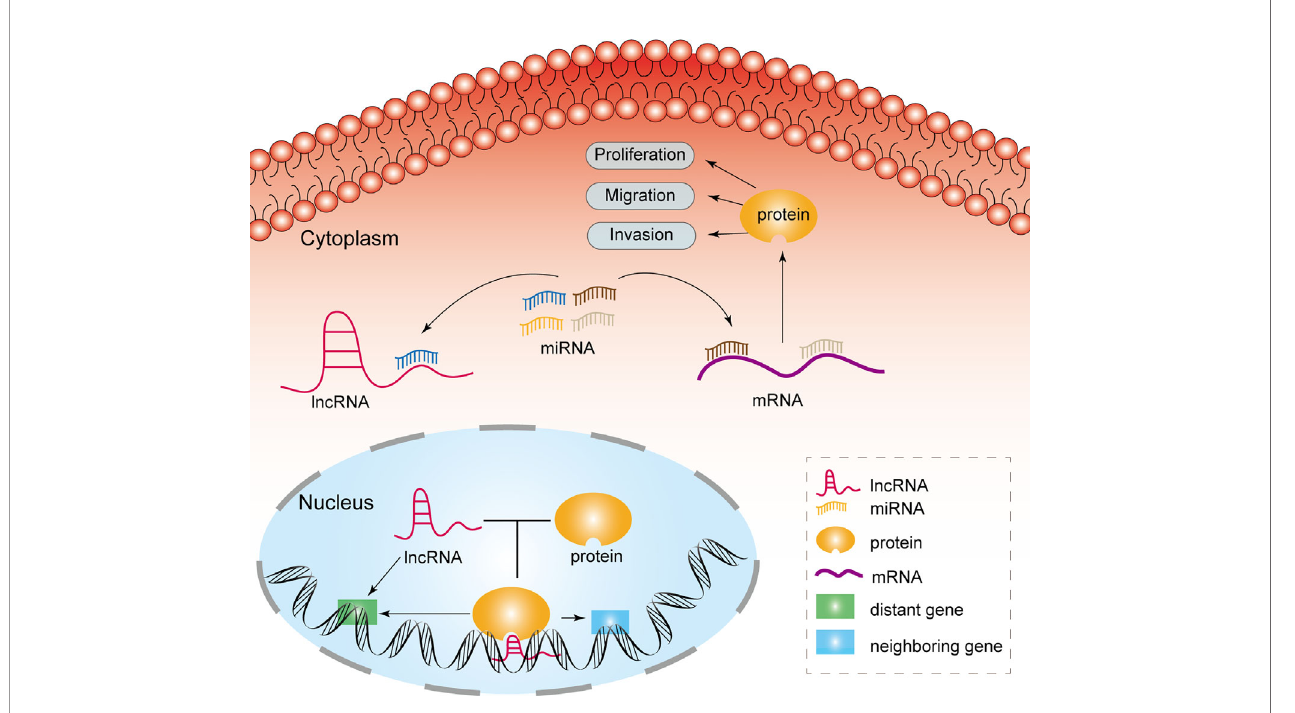
FIGURE 1 | Mechanisms of lncRNAs in glioma